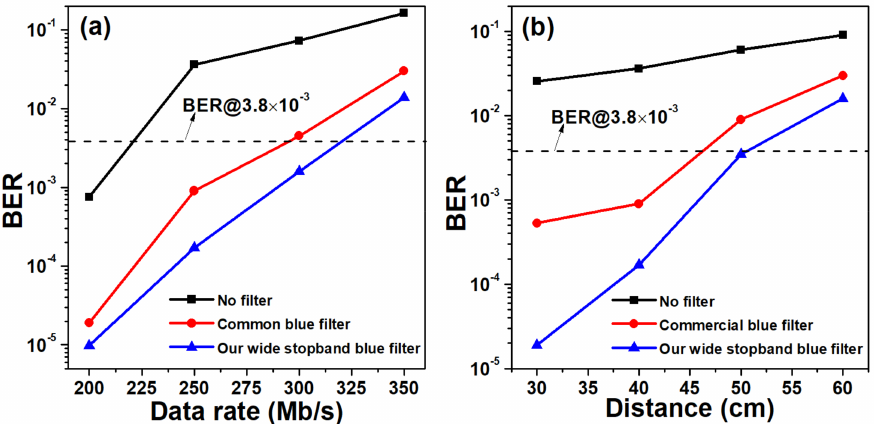
Figure 11. Measured BERs of downlink with no filter, common blue filter and filter versus ( a ) data rata and ( b ) distance. Reproduced with permission from [2], IEEE, 2015. (Reprinted from IEEE Wireless Communications, 22, Wang, S.-W. etc., A high-performance blue filter for a white-led-based visible light communication system. 61–67, Copyright (2015), with permission from